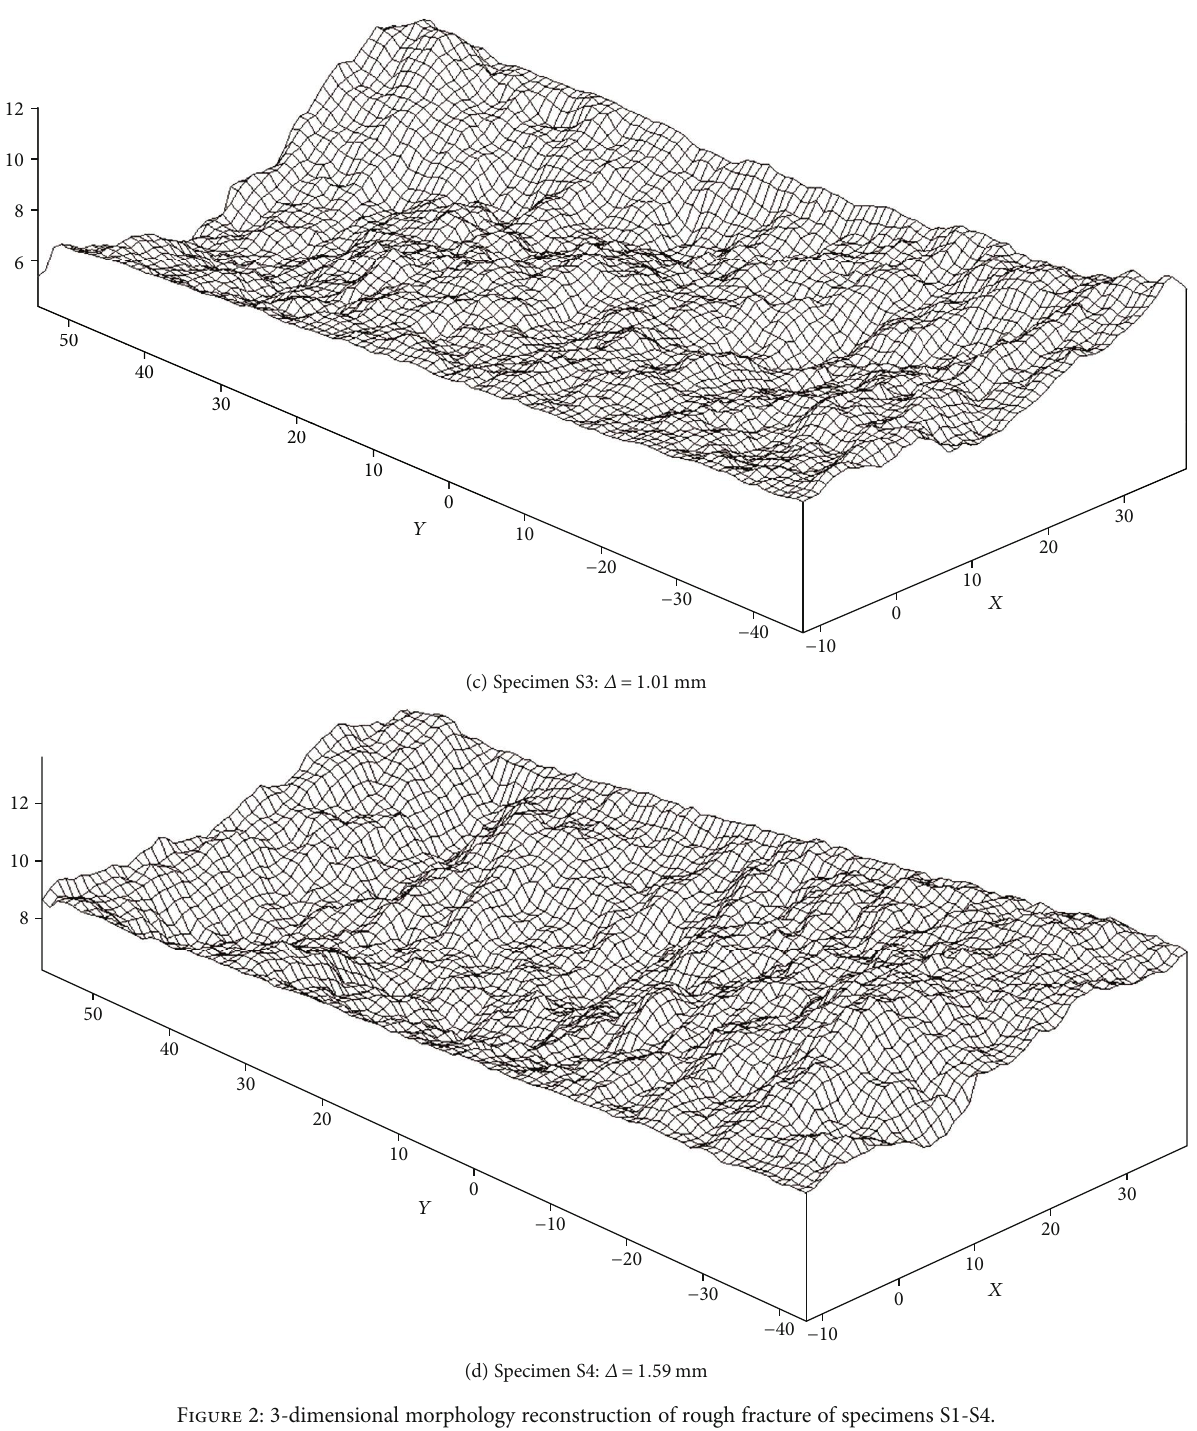
Figure 2: 3-dimensional morphology reconstruction of rough fracture of specimens